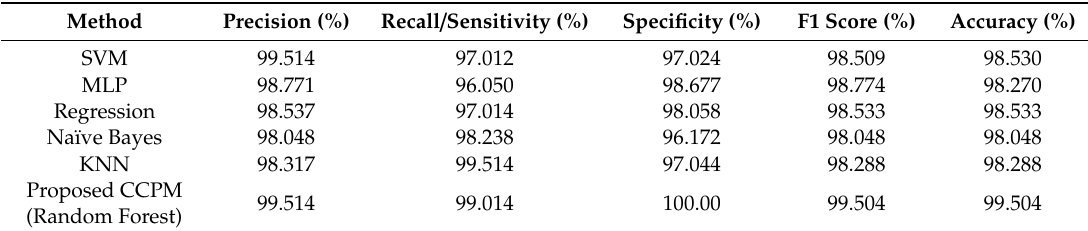
Table 16. Performance evaluation results based on iForest and SMOTE for Hinselmann.